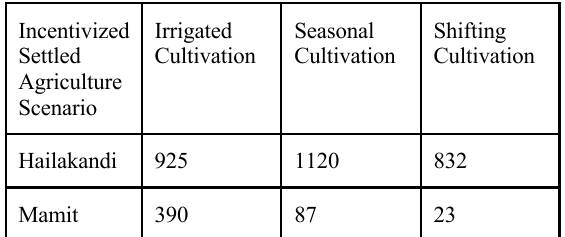
Figure 7. Land use map for 2035 when simulated with